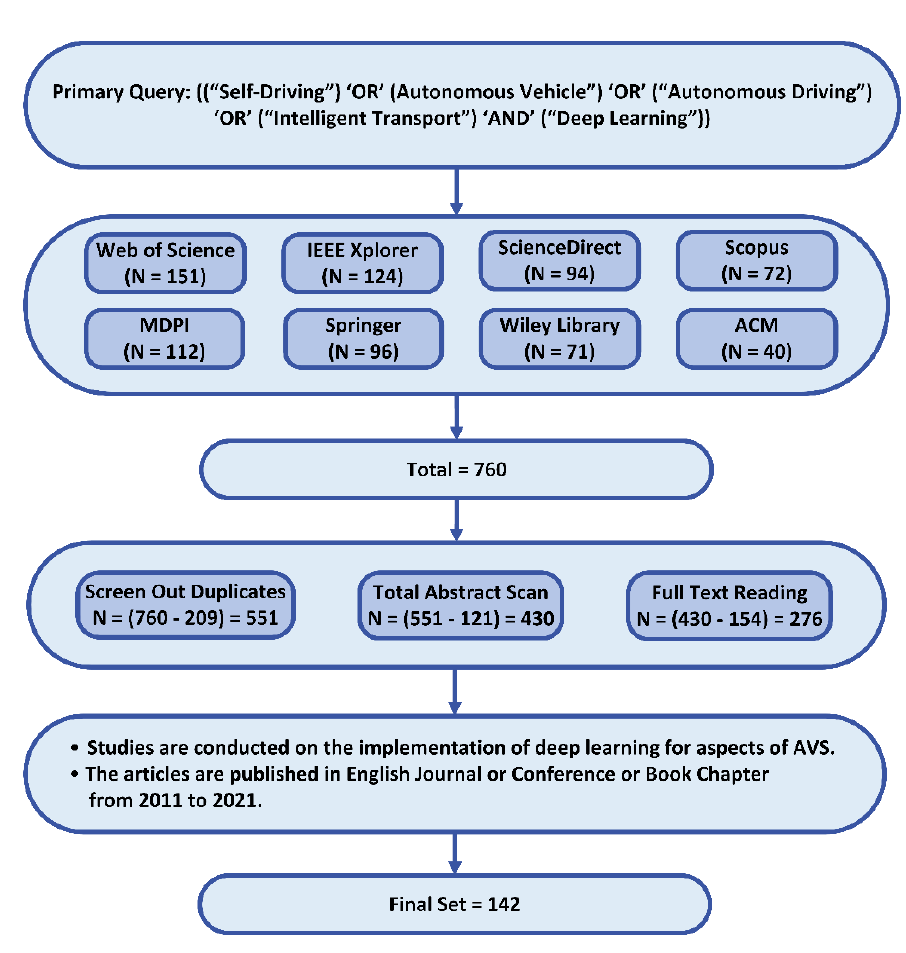
Figure 1. Framework for searching the literature and making the selection. Table 3. Paper selection from multiple